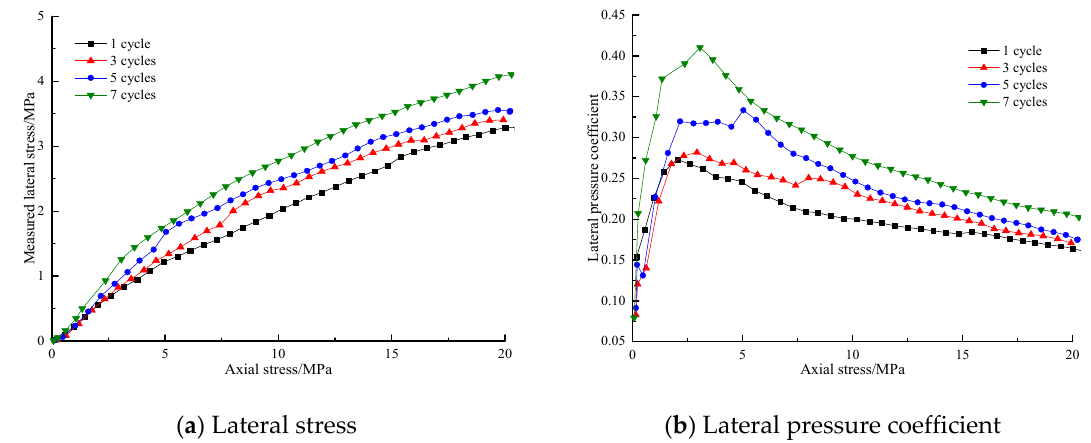
Figure 11. Changes in lateral stress and lateral pressure coefficients of samples during axial loading.